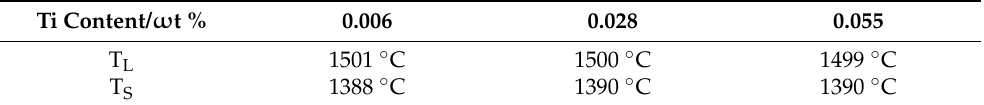
Table 3. Liquidus and solidus temperatures of three experimental